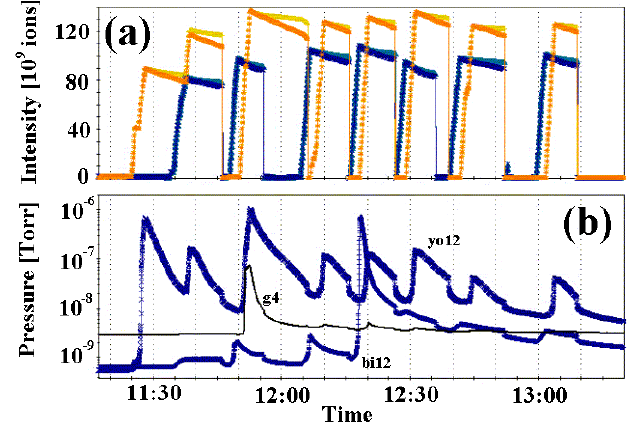
FIG. 25. (Color) Beam scrubbing during the 2007 Au operation. Part (a) shows the Blue and Yellow intensities over 2 hours when the machine was repeatedly filled with the highest available intensities. Part (b) shows the pressure near the warm rf (labeled g4) and the Blue and Yellow polarimeters (labeled bi12 and yo12, respectively), the 3 locations with the highest pressure. The dynamic pressure at these locations is reduced by more than an order of magnitude after